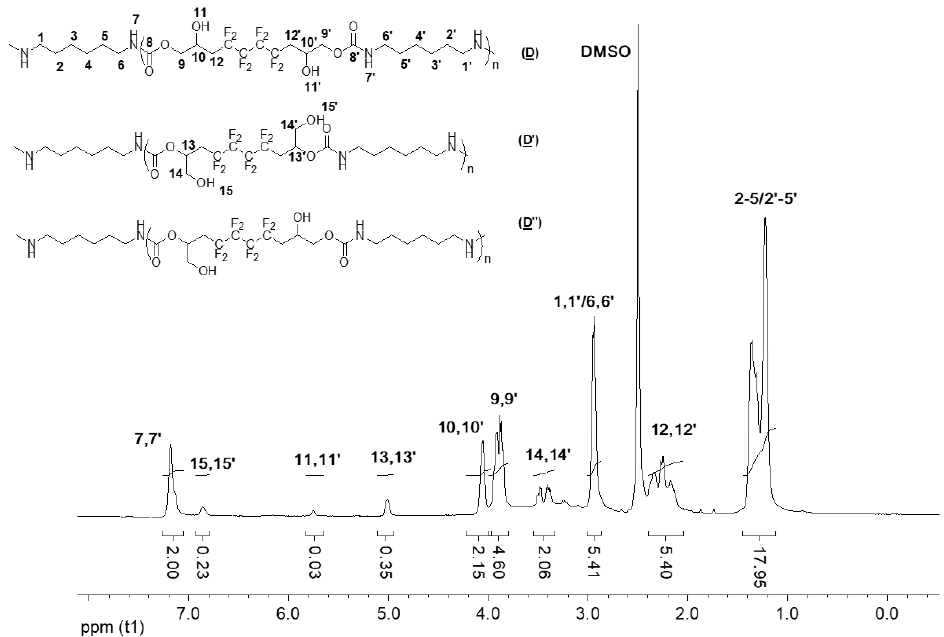
Figure 9. 1 H NMR spectrum of the synthesized P3 ( D ), ( D′ ), and ( D″ ) (DMSO-d6, 20 °C, 400 MHz) . Comparably, the 19 F NMR spectrum of P3 (Figure 10) is similar to that of the products of the model reaction and the synthesized bis-CC ( A ) (Figure S2 in the Supplementary Materials), showing the presence of the AB system at δ − 112 ppm, and the signal at δ − 123 ppm.